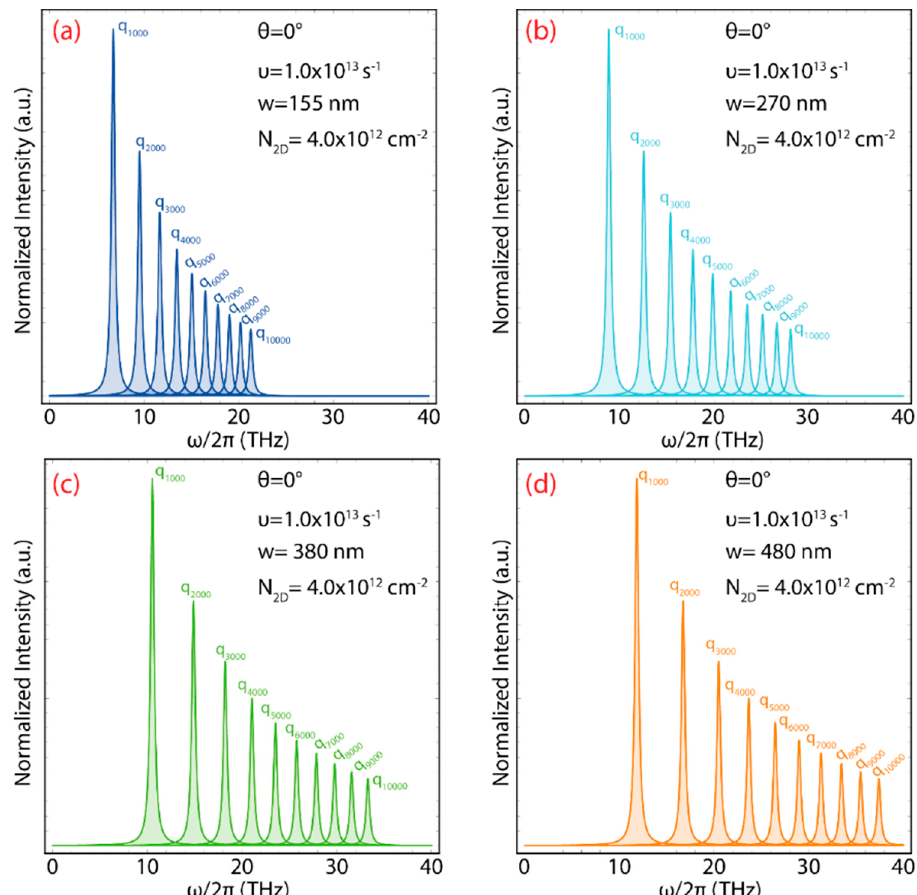
Figure 14. Plasmon excitation lifetime ( ω /2 π ≤ 40 THz) (using θ = 0, N 2 D = 4.0 × 10 12 cm − 2 , ν = 1.0 × 10 13 s − 1 , and v F = 0.829 × 10 6 m s − 1 ) for selected q values from 1000 to 10,000 cm − 1 , with different ribbon widths: ( a ) w = 155 nm, ( b ) w = 270 nm, ( c ) w = 380 nm, and ( d ) w = 480 nm. The plasmon spectra were calculated using the Lorentzian shape function to a maximum value of 1 with FWHM = 0.25 .